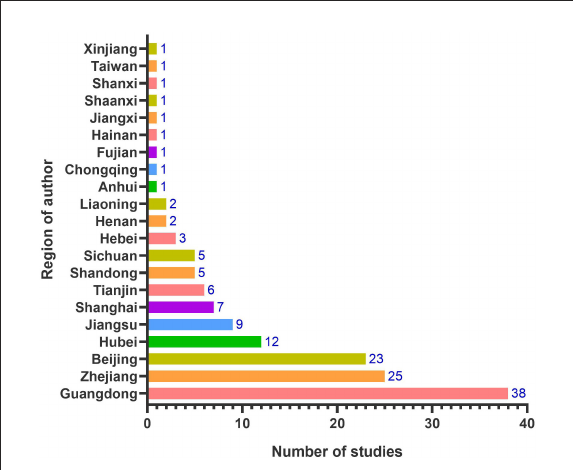
FIGURE2 Region distribution of included studies based on the institutions of the first